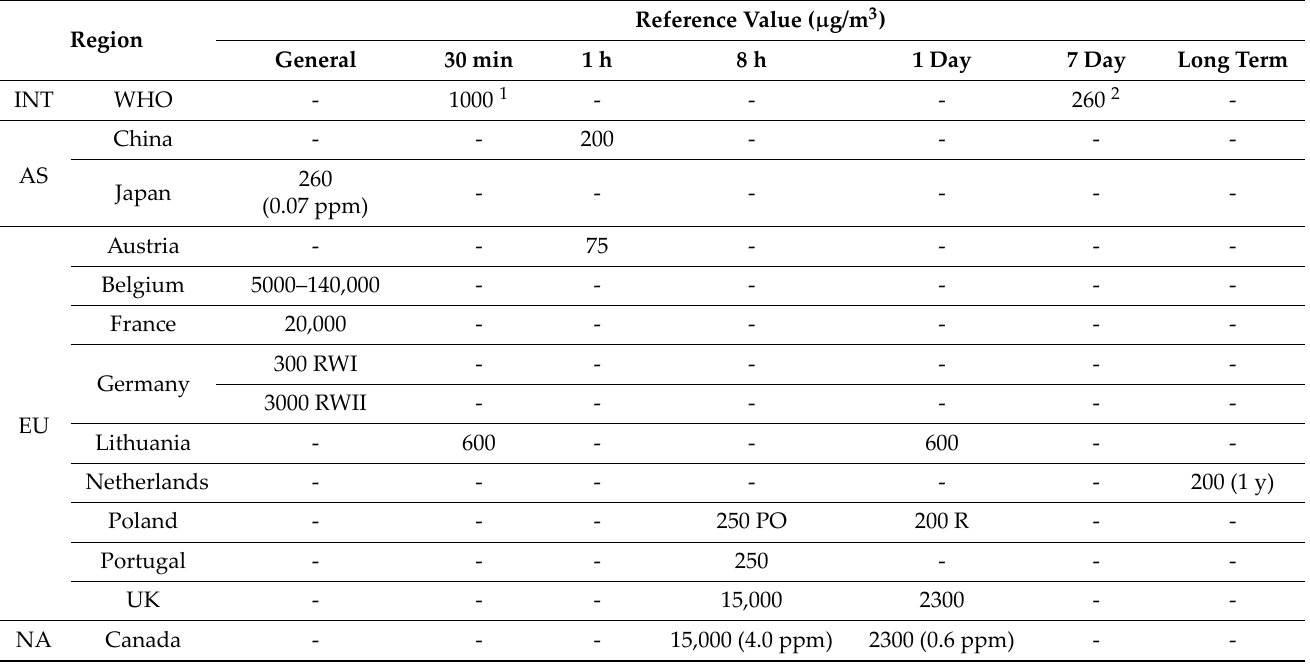
Table 19. Reference values for